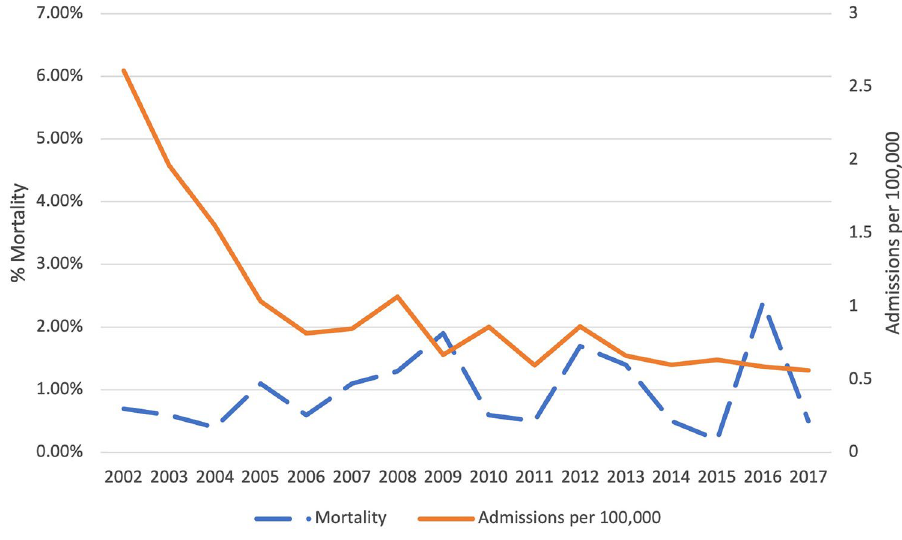
Fig. 2 Trends in inpatient mor- tality and admission rates over time for multiple myeloma in the United